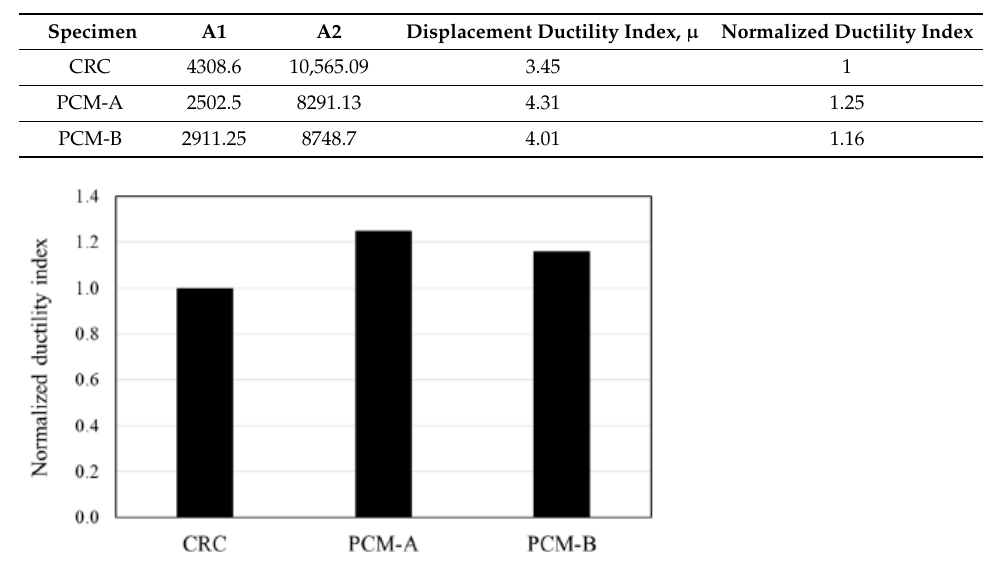
Figure 17. Diagram for the description of displacement ductility. Table 5. Comparison of displacement ductility index.